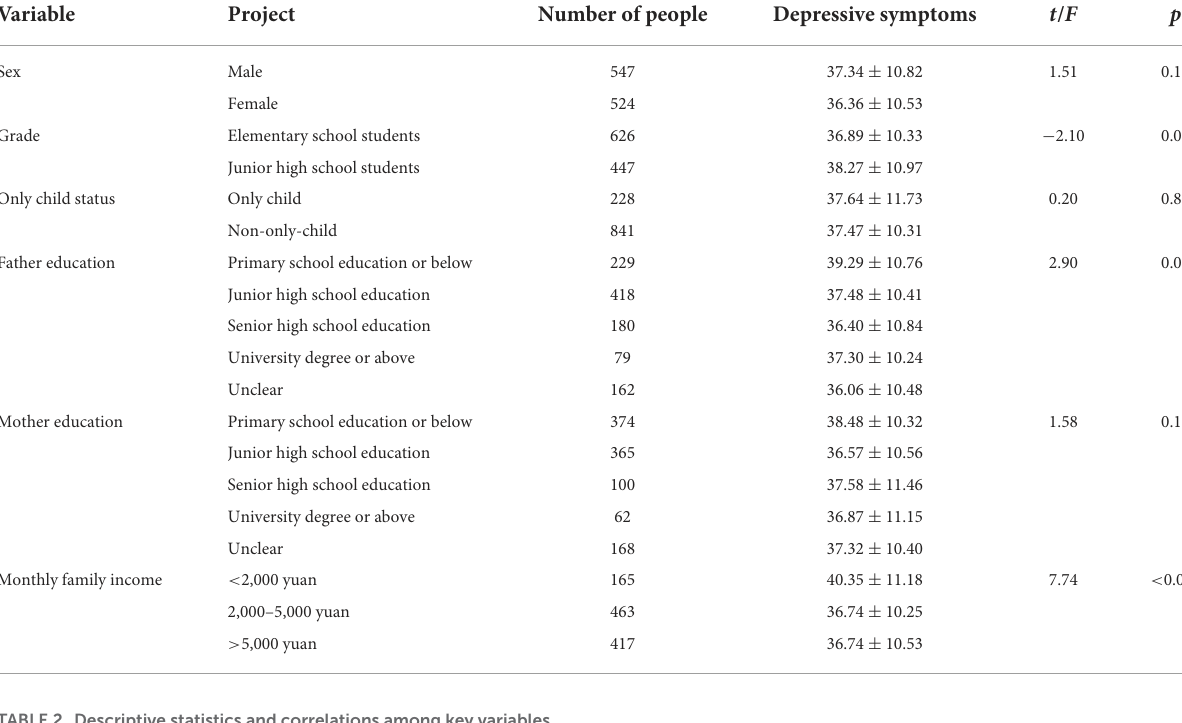
TABLE 1 Comparison of depressive symptoms scores of the migrant children with different demographic characteristics. Variable